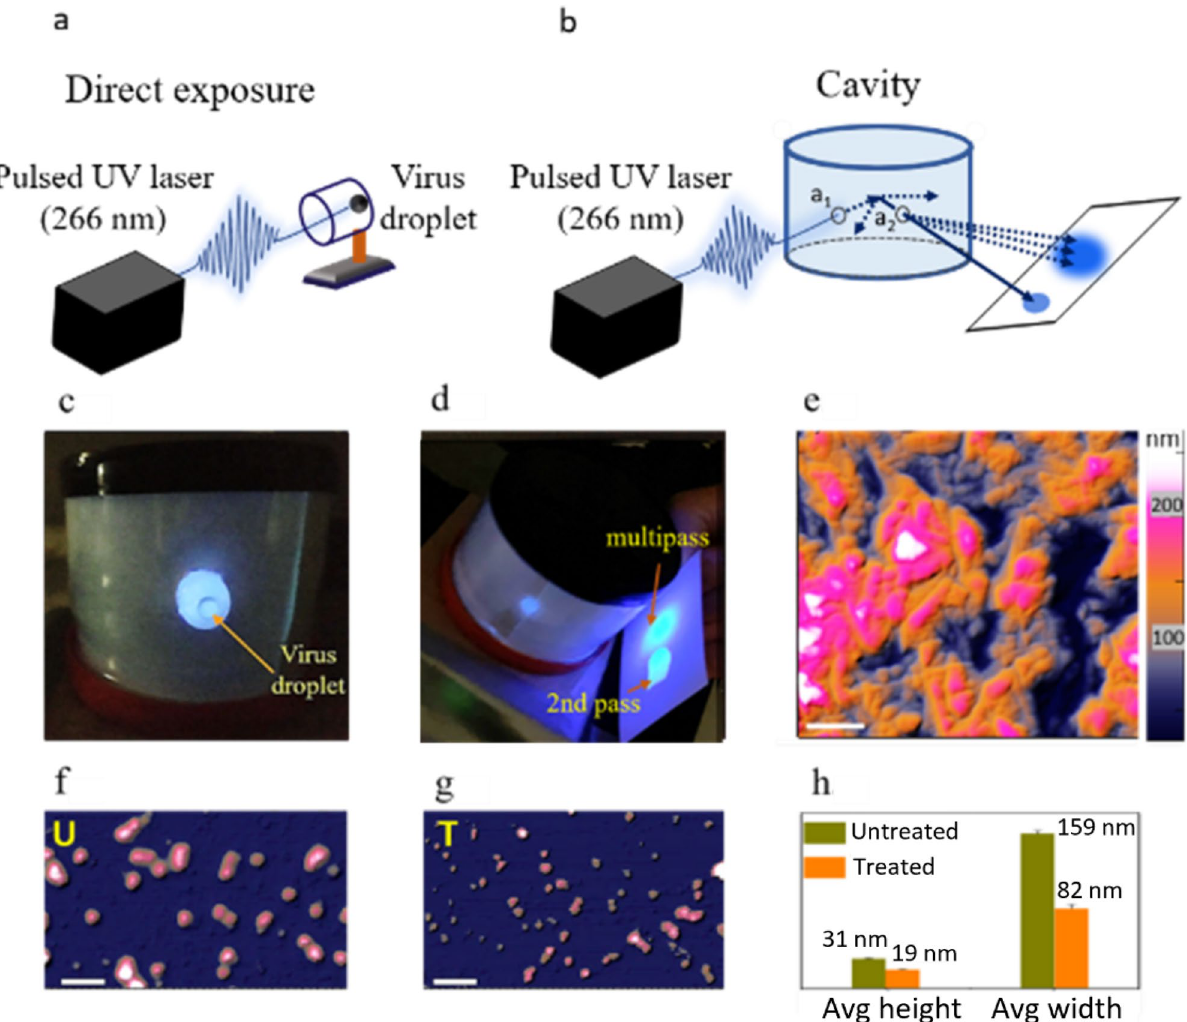
Figure 1. Virus inactivation using ultrafast UVC laser integrating cavity. ( a ) Schematic of the direct exposure of pulsed UVC laser on a droplet of virus solution in a vial. ( b ) Schematic of the LICD exposure of UVC laser irradiation on a droplet of virus placed inside the cavity at the location of aperture a 2 . ( c ) Photograph of the cavity with a virus droplet inside a vial. ( d ) Photograph of the cavity filled with UVC laser light and the reflection of fluorescence from the 2nd pass and multipass scattering as two bright spots on a white card, placed at the a 2 aperture. ( e ) AFM height image of PTFE sheet used as a diffuse reflective LICD cavity wall. ( f , g ) AFM height images of the untreated (U) and UVC laser treated (T) HCoV-229E virions. Scale bar is 0.3 µm. ( h ) Average height and width of the untreated and treated HCoV-229E